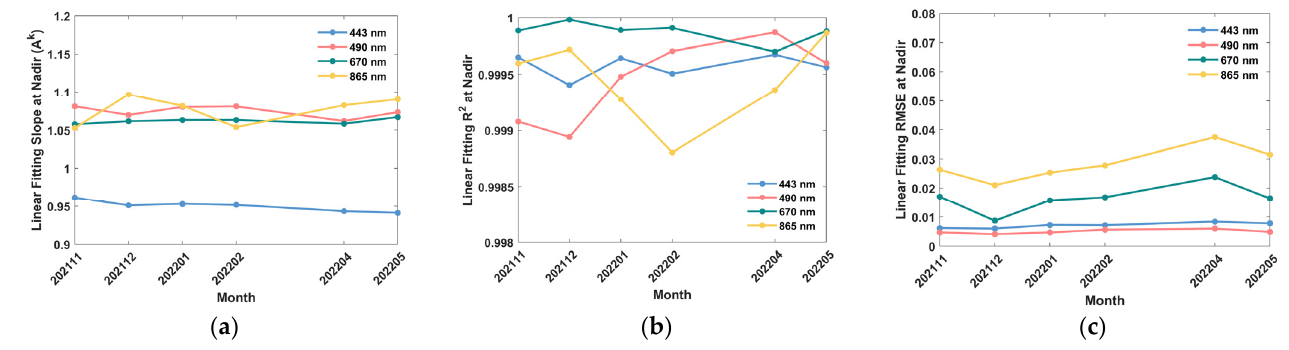
Figure 6. The time-varying characteristics of DPC and POSP normalized radiance linear fitting results ( a ) A k ; ( b ) R 2 ; and ( c ) RMSE in common spectral bands at nadir. These data pairs are selected from collections from November 2021 to May 2022 in DPC and POSP Level 1 products.